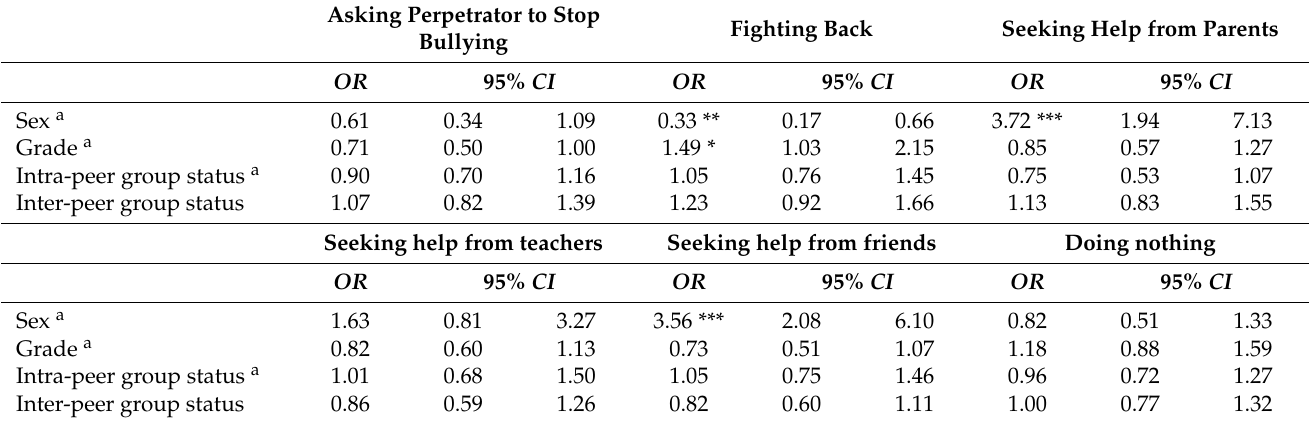
Table 3. Binominal logistic regressions for the six coping strategies ( n = 266).